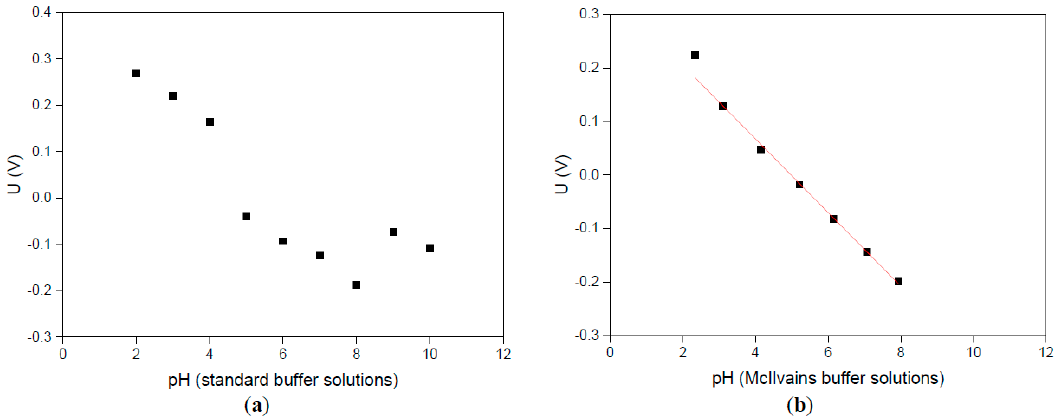
Figure 3. Characterization of the printed pH sensor with standard pH buffer solutions: ( a ) commercial pH buffers with different elemental structure and ( b ) McIlvains buffer